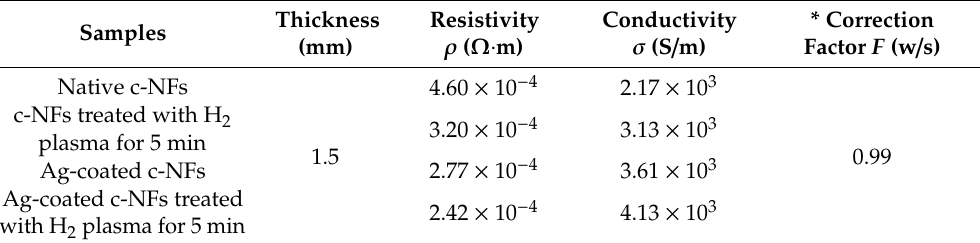
Table 3. Resistivity and electrical conductivity values of the studied samples.